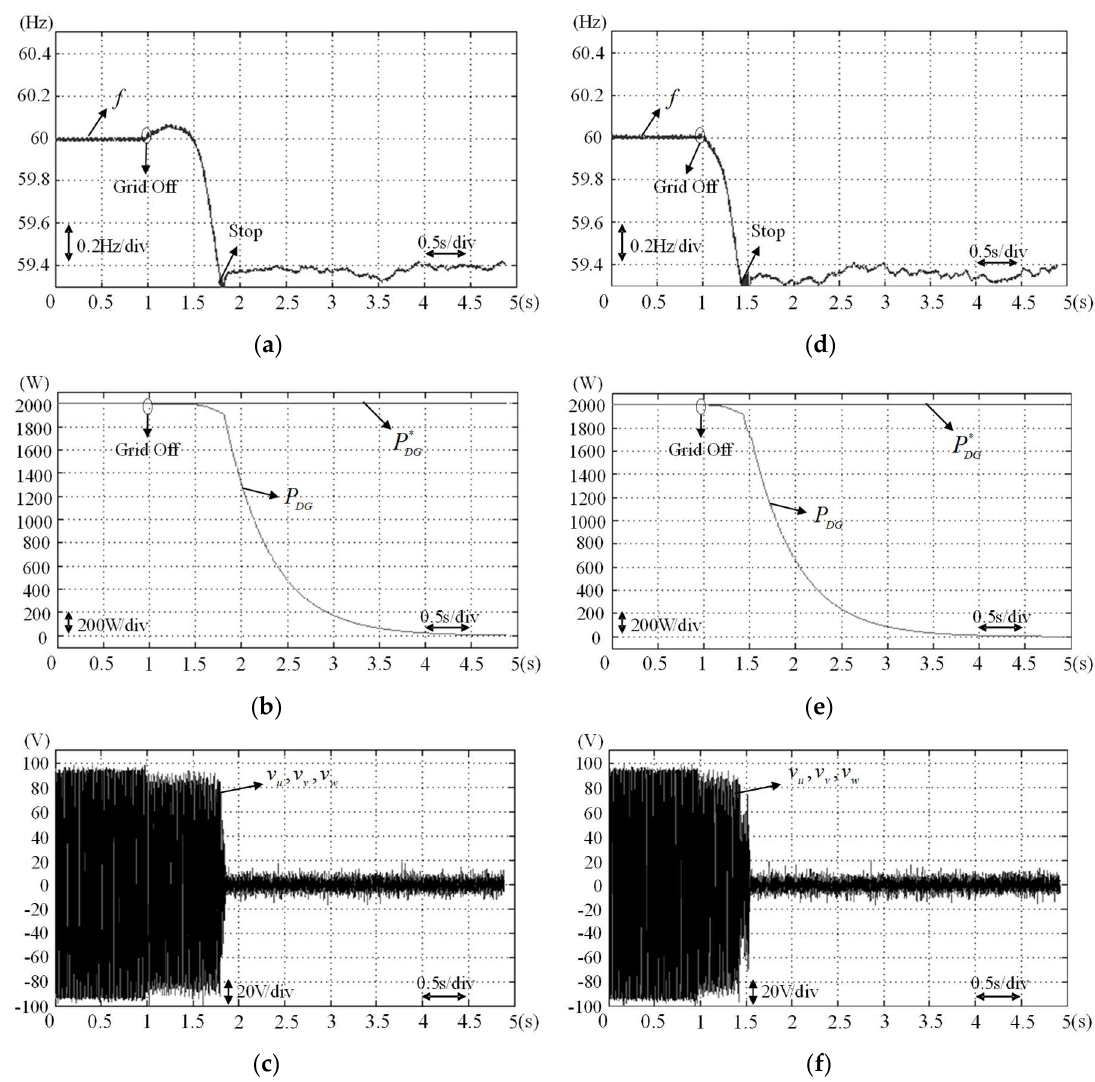
Figure 8. Experimental results of proposed active islanding detection method at case 1: ( a ) Frequency response using PI controllers; ( b ) Responses of active power output using PI controllers; ( c ) Voltage response using PI controllers; ( d ) Frequency response using adopted PFNN controllers; ( e ) Responses of active power output using adopted PFNN controllers; ( f ) Voltage response using adopted PFNN controllers.